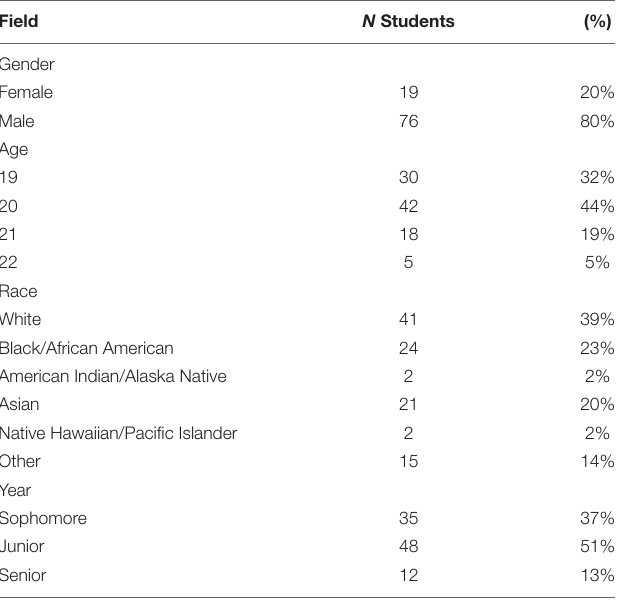
TABLE 1 | Demographics of the undergraduate college